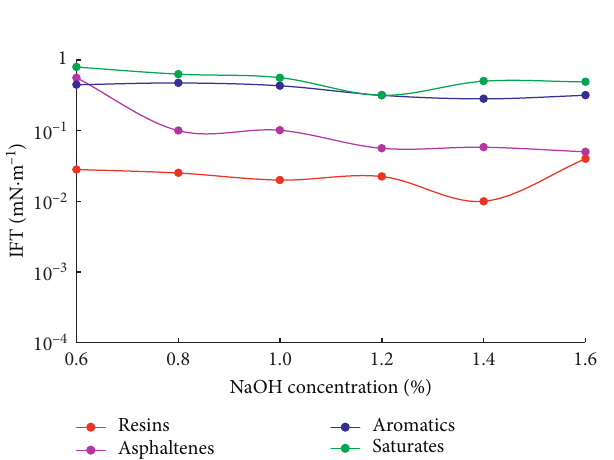
Figure 7: IFT affected by different oil groups [83]. Table 11: Oil composition comparison